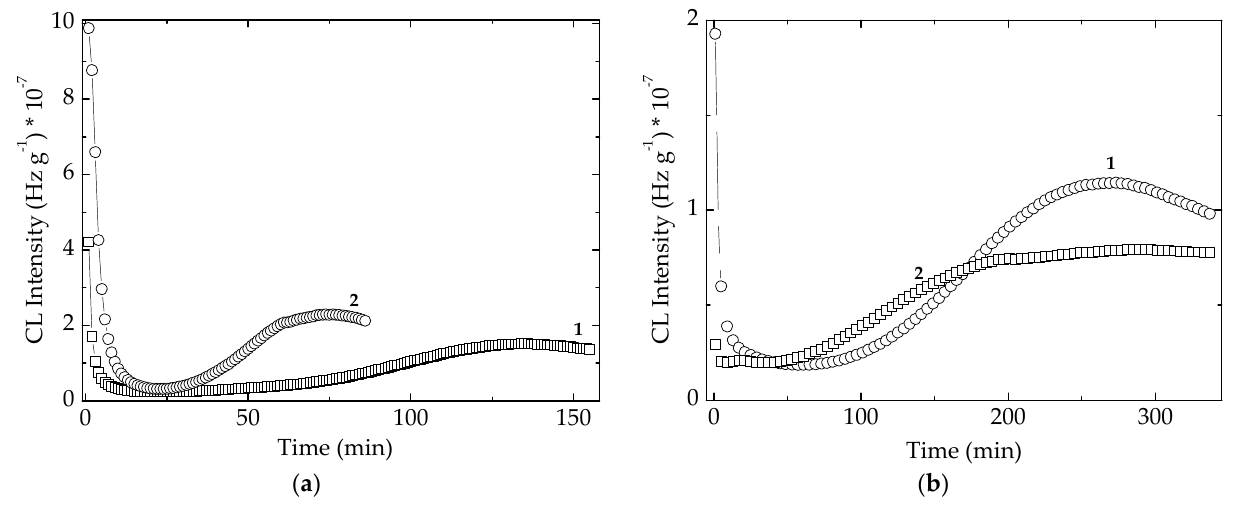
Figure 8. Comparative illustration of the isothermal CL spectra recorded on the unirradiated EPDM samples containing algal extracts and POSS. ( a ) Spirulina platensis ; ( b ) Chlorella vulgaris. Dose: 0 kGy; Testing temperature: 170 °C. (1) POSS + algal extract; (2) algal extract.